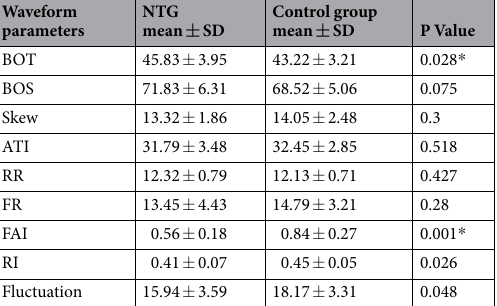
Table 2. Differences in waveform parameters describing the curve of mean blur rate in the area of the capillaries (MT). (NTG) Normal tension glaucoma. (SD) Standard deviation. (BOT) Blow out time. (BOS) Blow out score. (ATI) Acceleration time index. (RR) Rising rate. (FR) Falling rate. (FAI) Flow acceleration index. (RI) Resistivity index. Data were adjusted for the heart rate. ( * Marks statistical